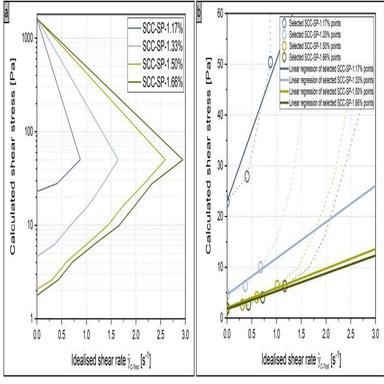
Flow curve of the SCC-SP-X mixes, with an idealised (not comparable to reality) shear rate (b) A focused representation of the flow curve involving linear regression (fixed intercept at yield stress) of the measuring points located between yield stress and lowest apparent viscosity.